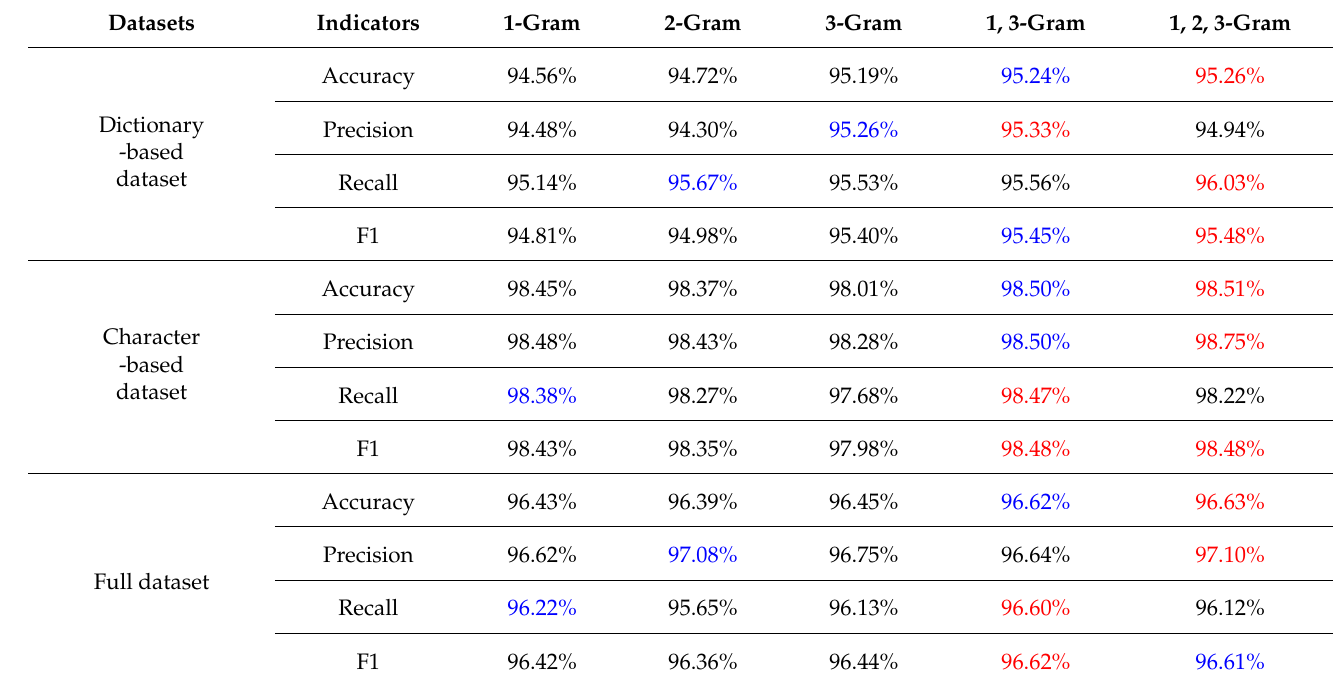
Table 8. Performance of different n-gram sequence